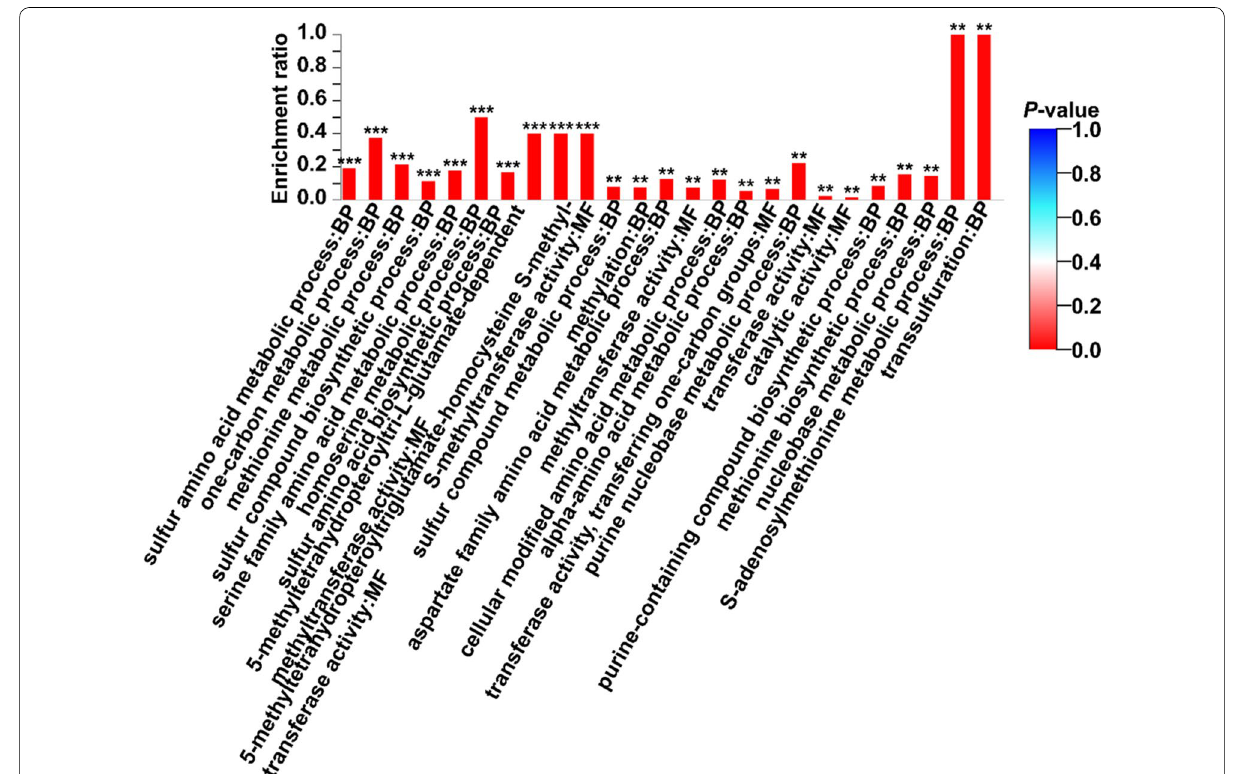
Fig. 4 GO annotation of upregulated proteins on day 10. * P < 0.05, ** P <